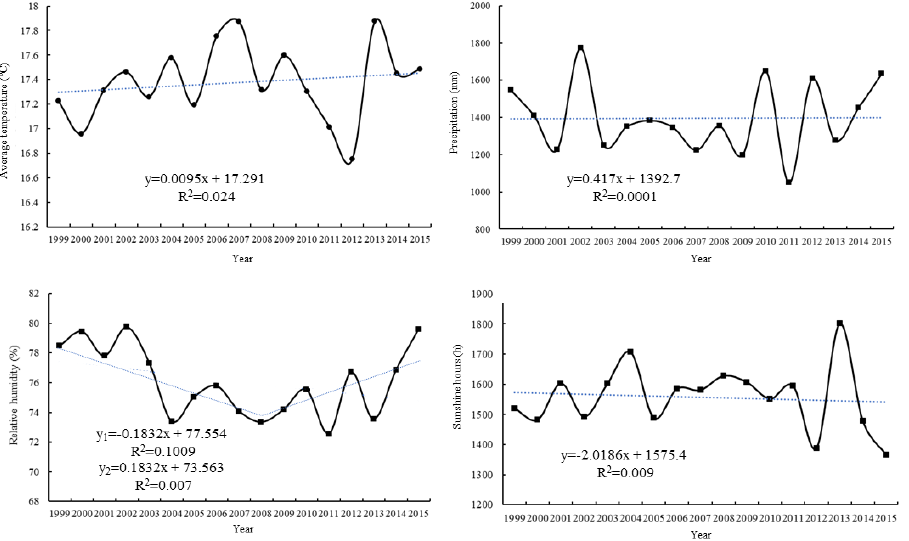
Figure A1. Trends in temperature changes in the middle reaches of the Yangtze River from 1999 to 2015.